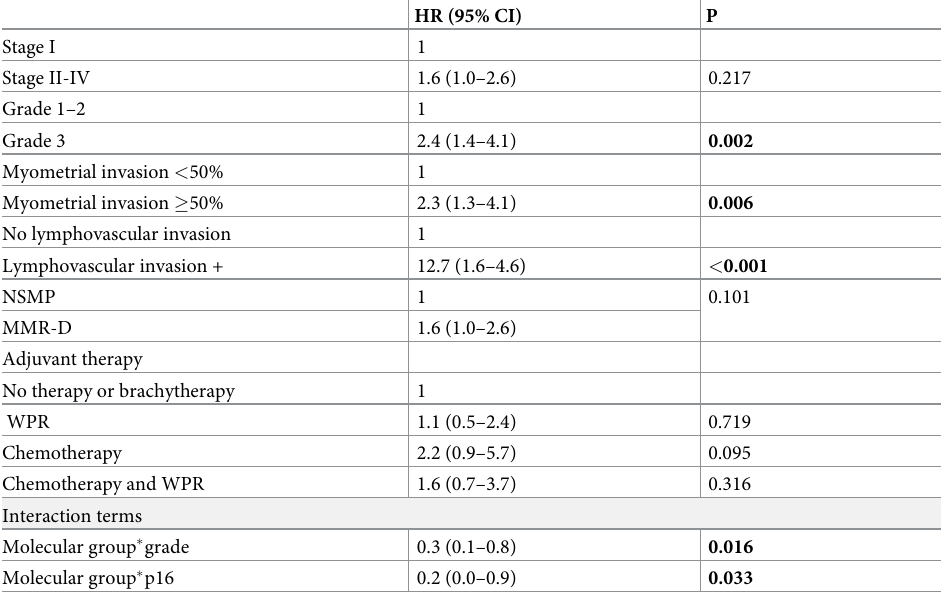
Table 3. Multivariable Cox regression analysis of disease-specific survival in stage I-IV NSMP/MMR-D endome- trial carcinoma (n =